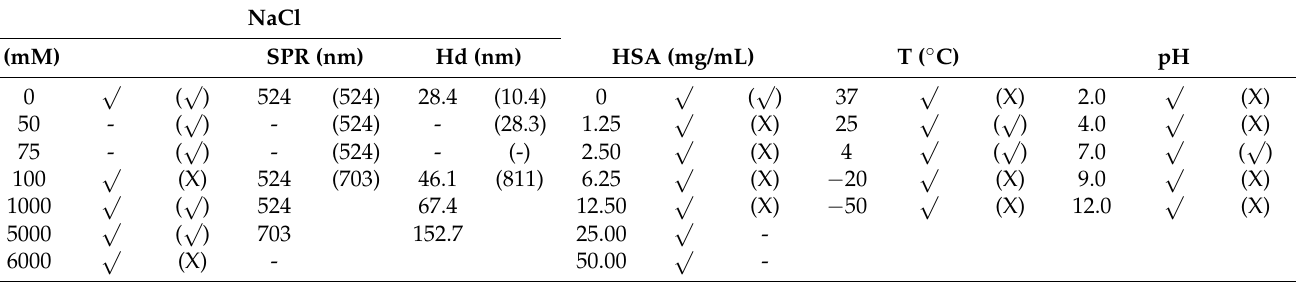
Table 1. Stability of sAuNPs and cAuNPs (in parentheses) under varying NaCl concentrations, human serum albumin (HSA) concentrations, temperature, and pH.